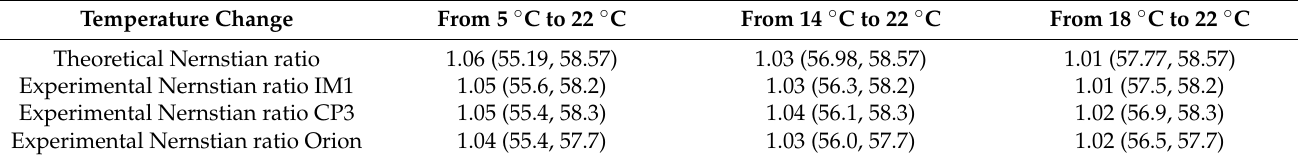
Table 2. Theoretical and experimental ratio of Nernstian slopes at different temperatures in the calibration of K-ISE. The values of the slopes in mV/decade are given in parenthesis. Temperature Change From 5 ◦ C to 22 ◦ C From 14 ◦ C to 22 ◦ C From 18 ◦ C to 22 ◦ C Theoretical Nernstian